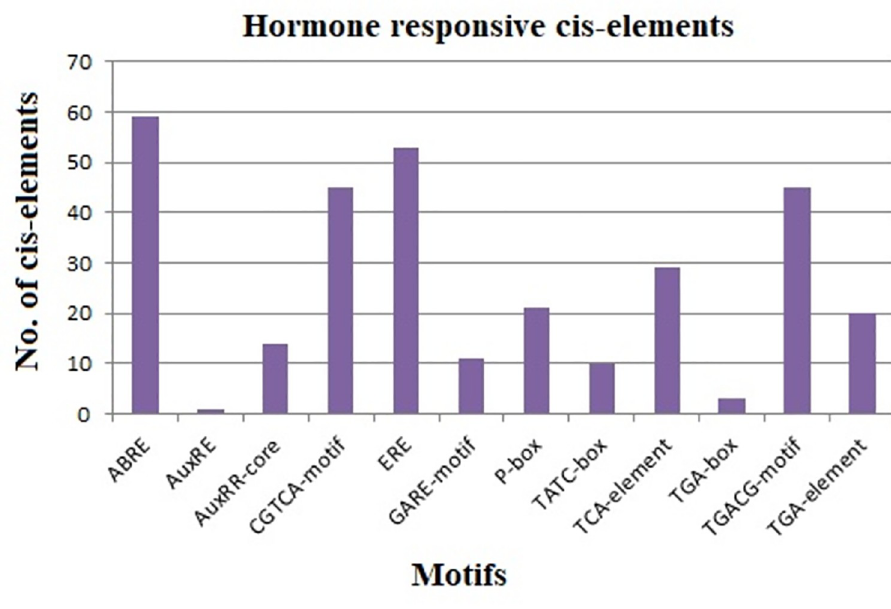
Fig 8. Graphical illustration of hormone responsive elements in StDREBs. The ABRE showed the highest frequency followed by ERE, CGTCA-motif and TGACG-motif, respectively.